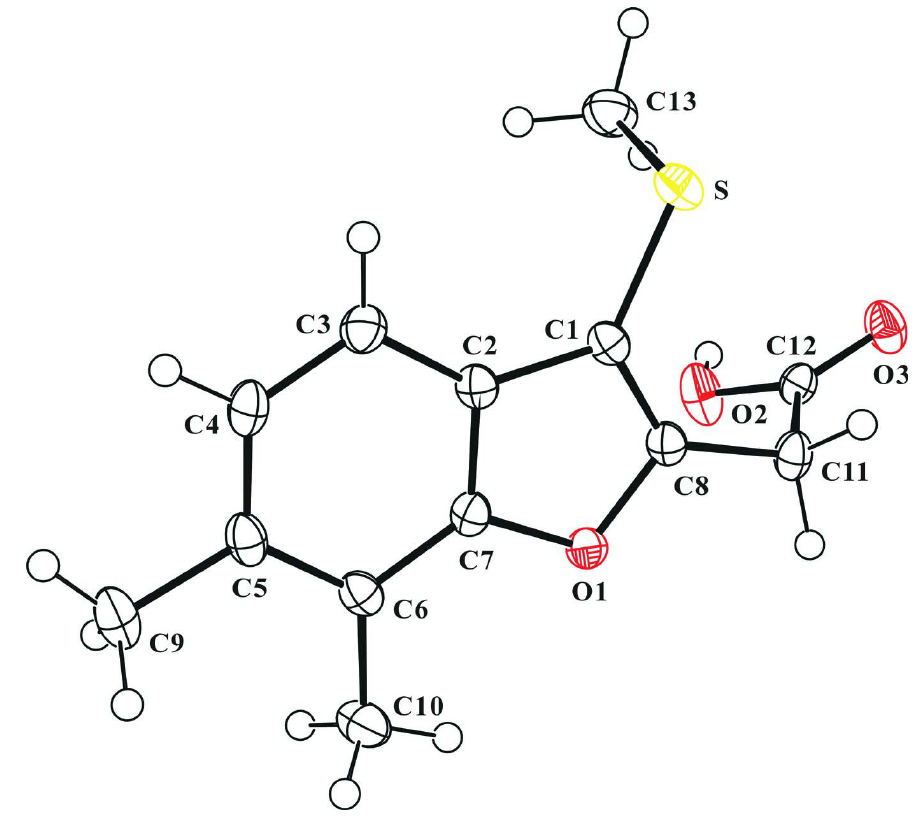
Figure 1 The molecular structure of (I), showing displacement ellipsoids for the non-hydrogen atoms drawn at the 50% probability